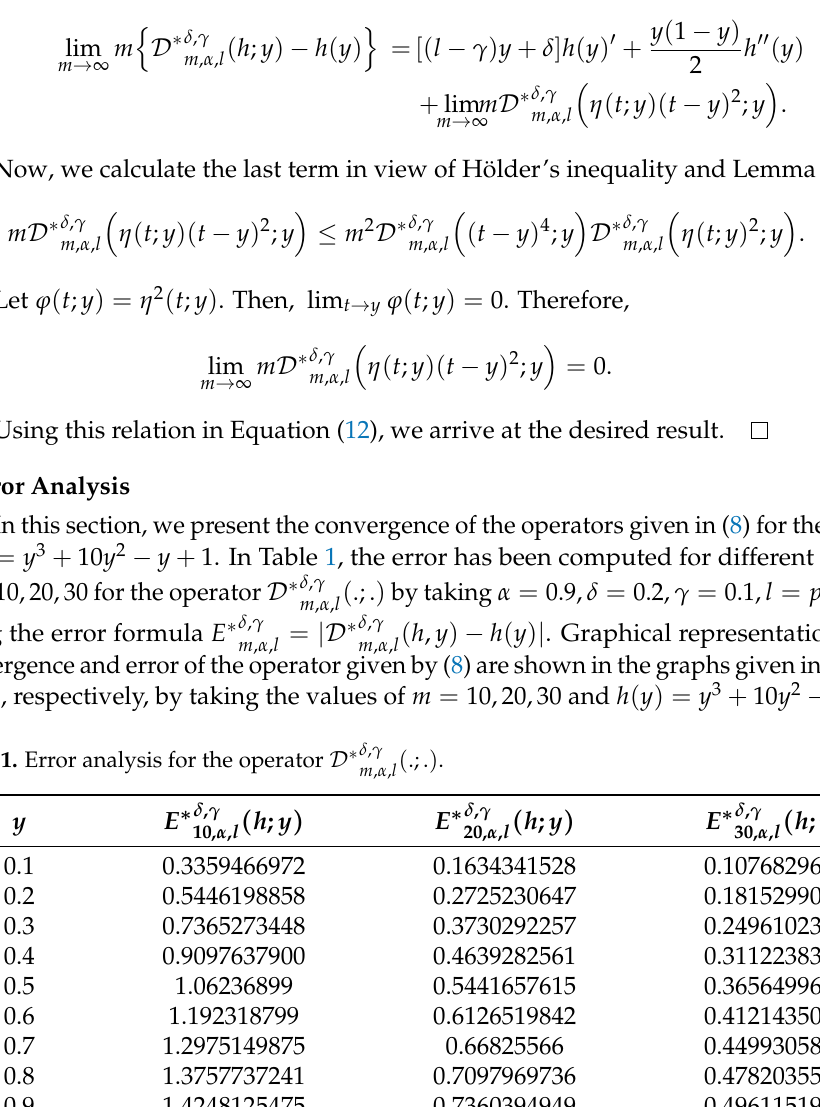
Table 1. Error analysis for the operator D ∗ δ , γ